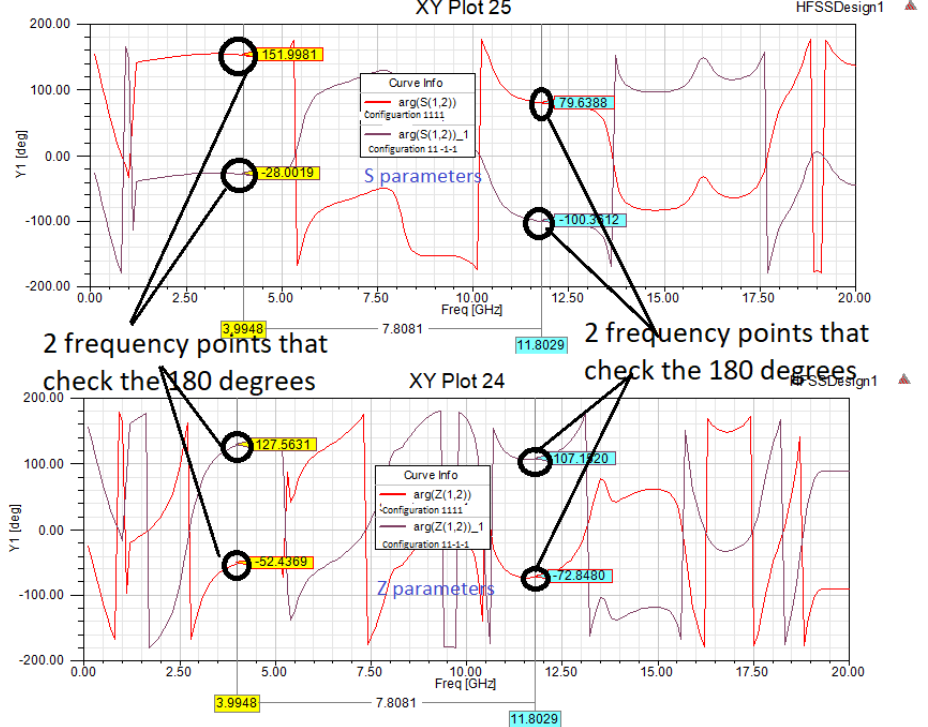
Figure 9. Arg (S12) and Arg (Z12) between two sources of four antennas in two different symmetry configurations 1111 and 11 − 1 − 1: The frequency range from 0 to 20 GHz . (Simulation under HFSS) (It checks Φ 2 − Φ 1 = π (See after Equation